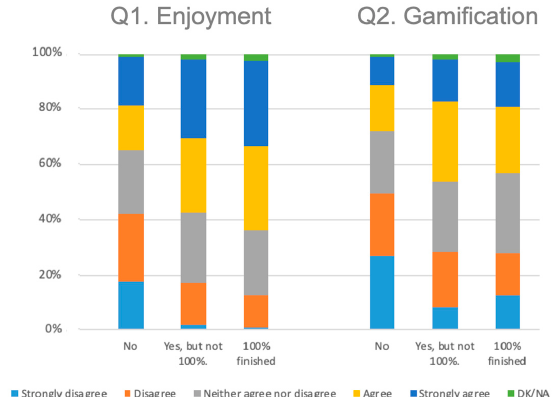
Figure 6. Relationship between learning, enjoyment, gamification and completion of MOOC.